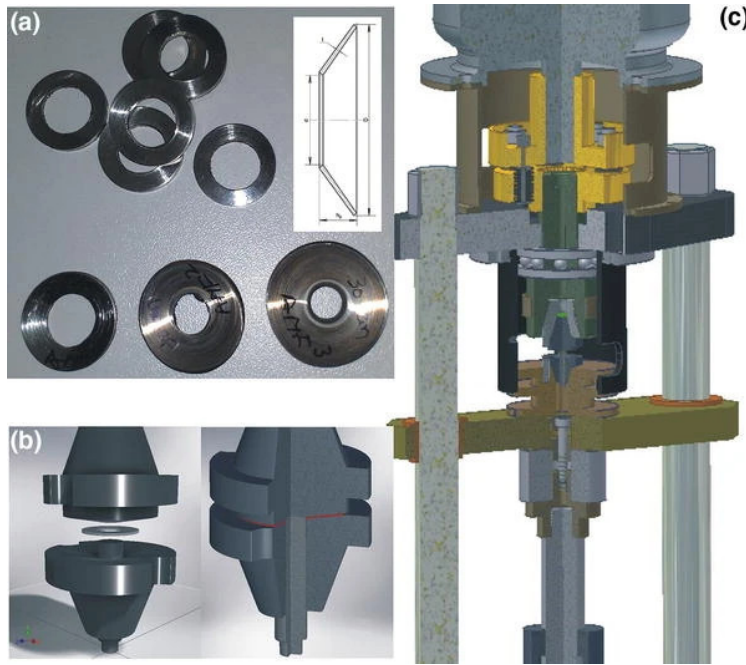
Figure 8. HSHPT technology: ( a ) disk-shaped samples and their geometry, and final shapes of Fe–Mn–Si–Cr SMA coned disk spring-shape modules, ( b ) HSHPT upper and lower anvils with open and closed conditions, and ( c ) HSHPT machine, adapted with permission from [96], 2023, Springer Nature.